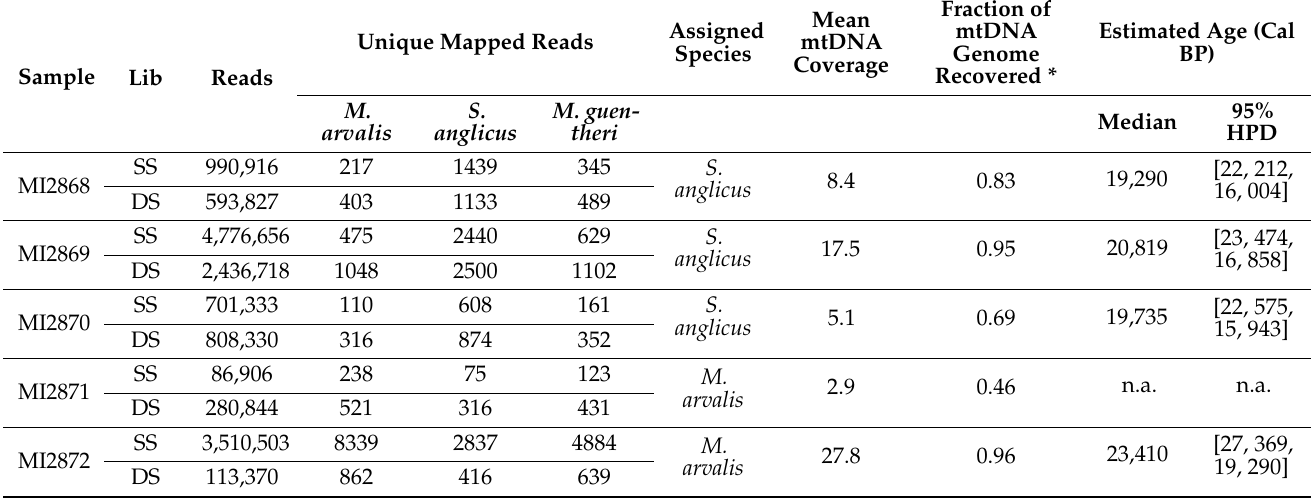
Table 1. Genetic assignment of Les Petit Guinards samples. Lib: DNA library type; DS–double stranded; SS–single stranded. For each sequencing library the highest number of mapping reads is given in